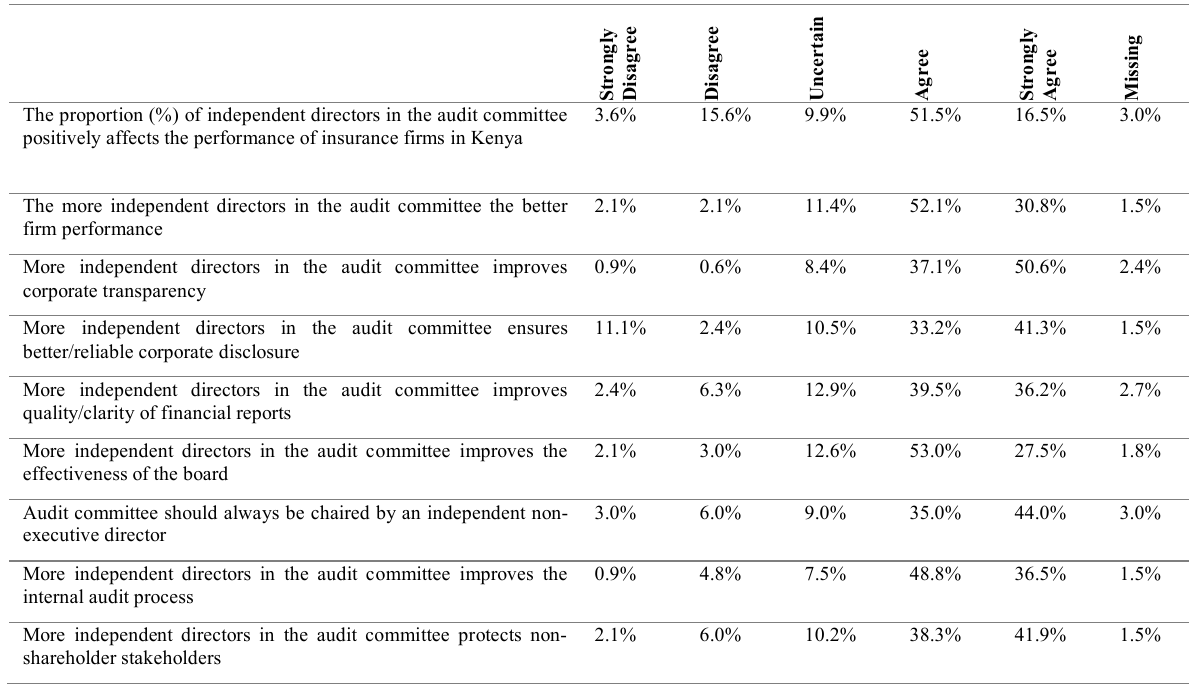
Table 2: Frequency and Percentage Distribution for AUDIND